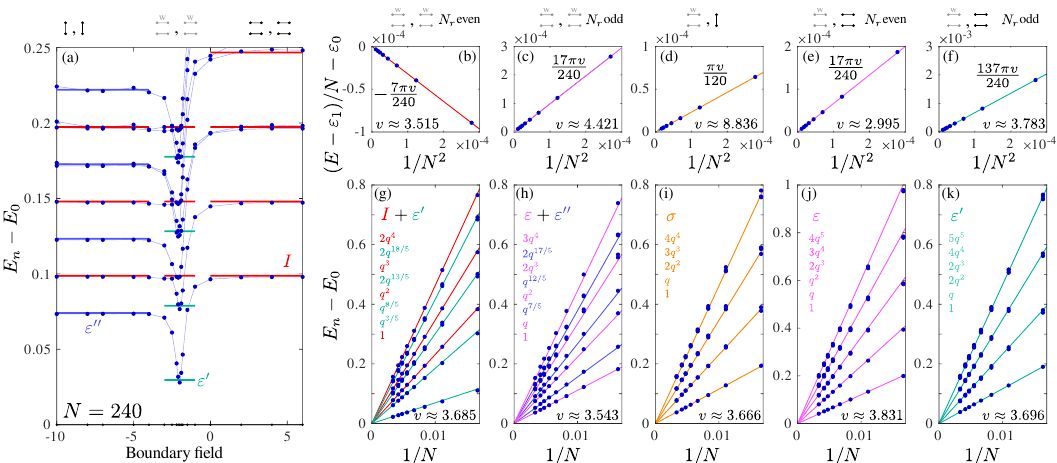
Figure 14: (a) Finite-size excitation spectrum as a function of the external boundary field applied at the first and last rungs of the ladder. Blue dots are DMRG data. Red, blue and green lines corresponds to the CFT prediction for I, (cid:34) (cid:48)(cid:48) , and (cid:34) (cid:48) towers and v = 3.77. (b-f) Finite-size scaling of the ground-state energy for various boundary conditions, indicated on top of each panel. ’W’ corresponds to the weak boundary field h = − 2. (g-k) Finite-size scaling of the excitation energies with various bound- ary conditions. Blue dots are DMRG data. The velocities indicated in each panel are obtained by a numerical fit of the ground-state energy (a-f) or of the lowest excita- tion energies (g-k). Color lines are CFT prediction for partially polarized and mixed boundary conditions. The degeneracy of each level matches the CFT predictions, indicated as columns below the primary fields inside each